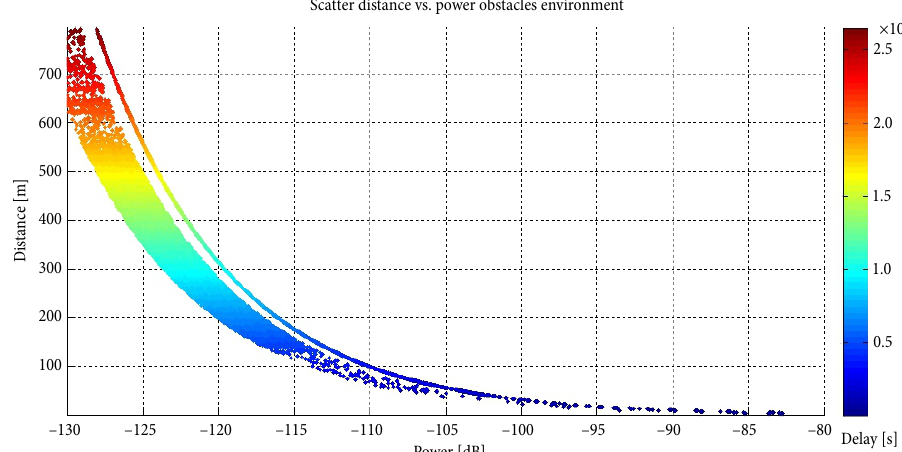
Fig. 8. Scatter function of the distance vs. received power for a non-obstacle scenario Scatter distance vs. power obstacles